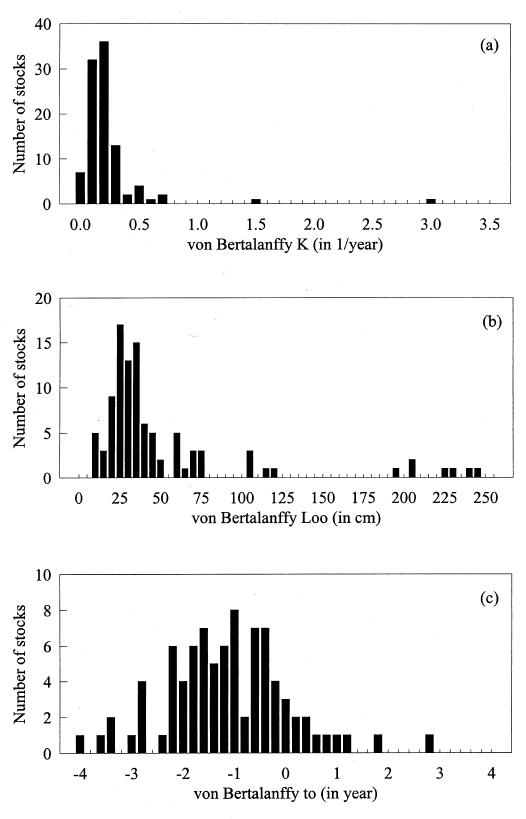
Fig. 2. The von Bertalanffy (a) K, (b) L a variety of fish stocks in Hellenic